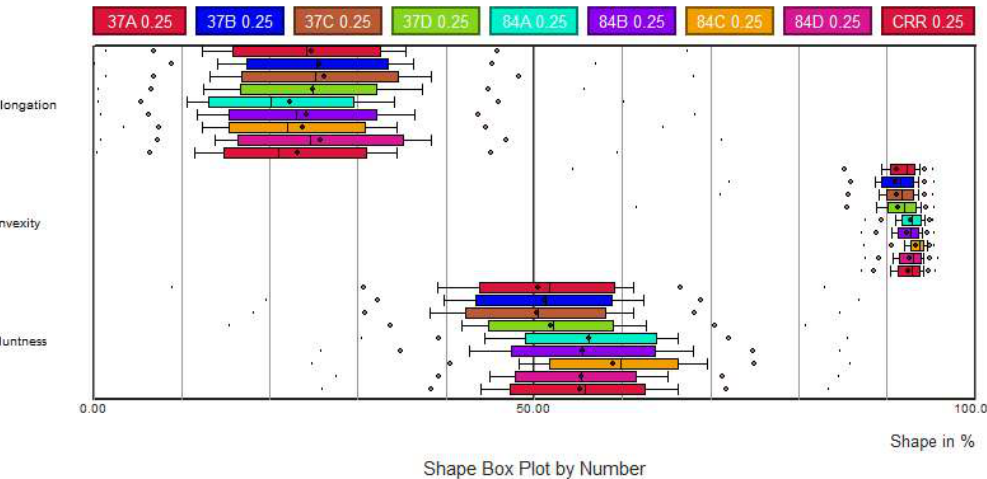
Materials 2020 , 13 , x FOR PEER REVIEW Figure A5. Shape analysis of particles (0.25–0.5 mm). Figure A5. Shape analysis of particles (0.25–0.5 mm).